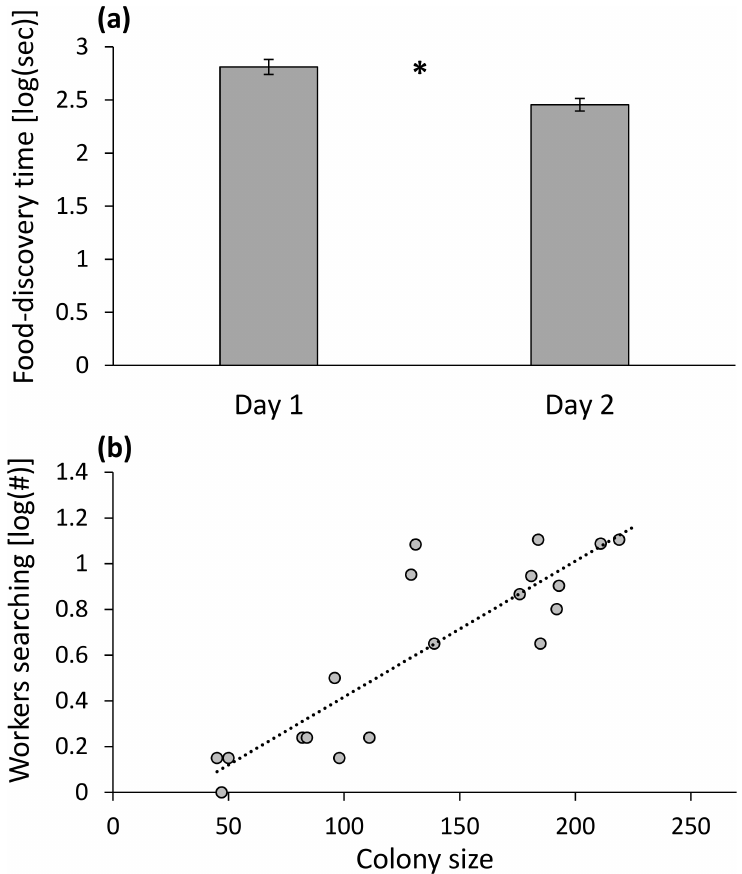
Fig 3. (a) The decreasein food-discovery time betweenthe first tests on two successivedays; (b) the positive correlationbetweencolony size and the numberof workers searching(mean values for the first tests on the two successivedays are presented).The asterisk indicatesa significantdifference.